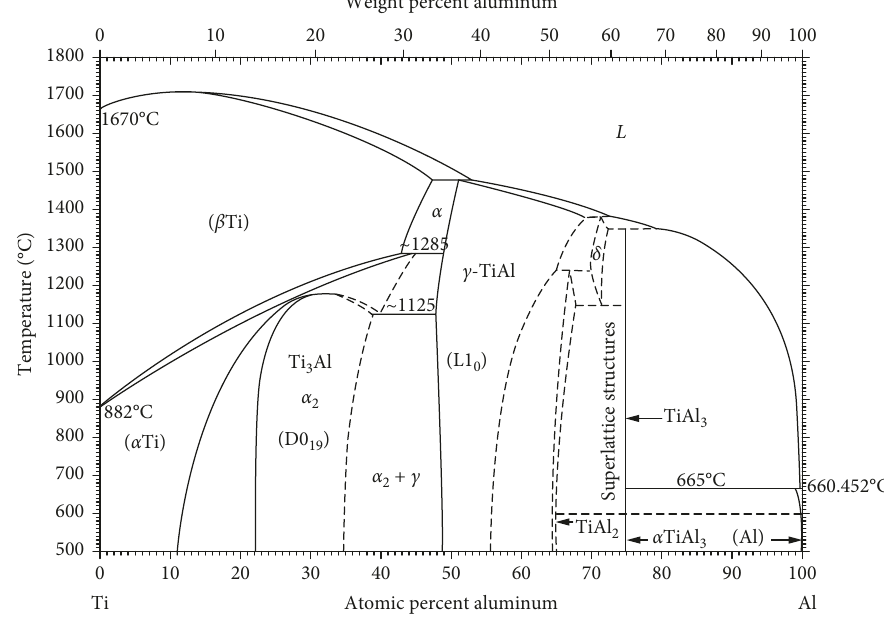
Figure 3: Binary phase diagram of TiAl alloy [3].